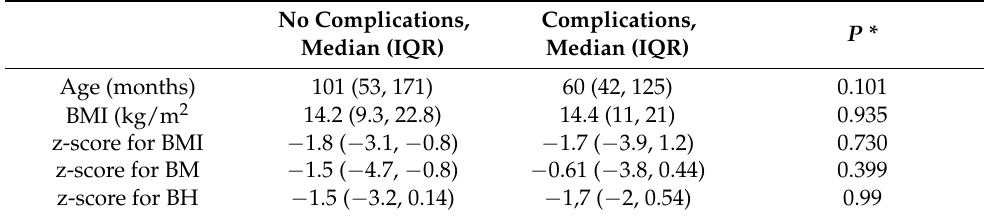
Table 4. Analysis of age, BMI, and z-score for BMI, BM and BH in patients without and with complications related to